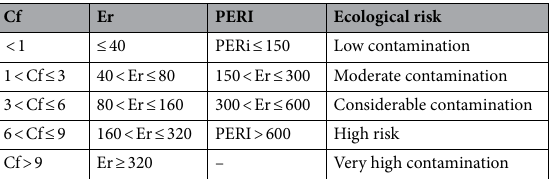
Table 6. Grading of contamination factor (Cf), the potential ecological risk coefficient (Er) and potential ecological risk index